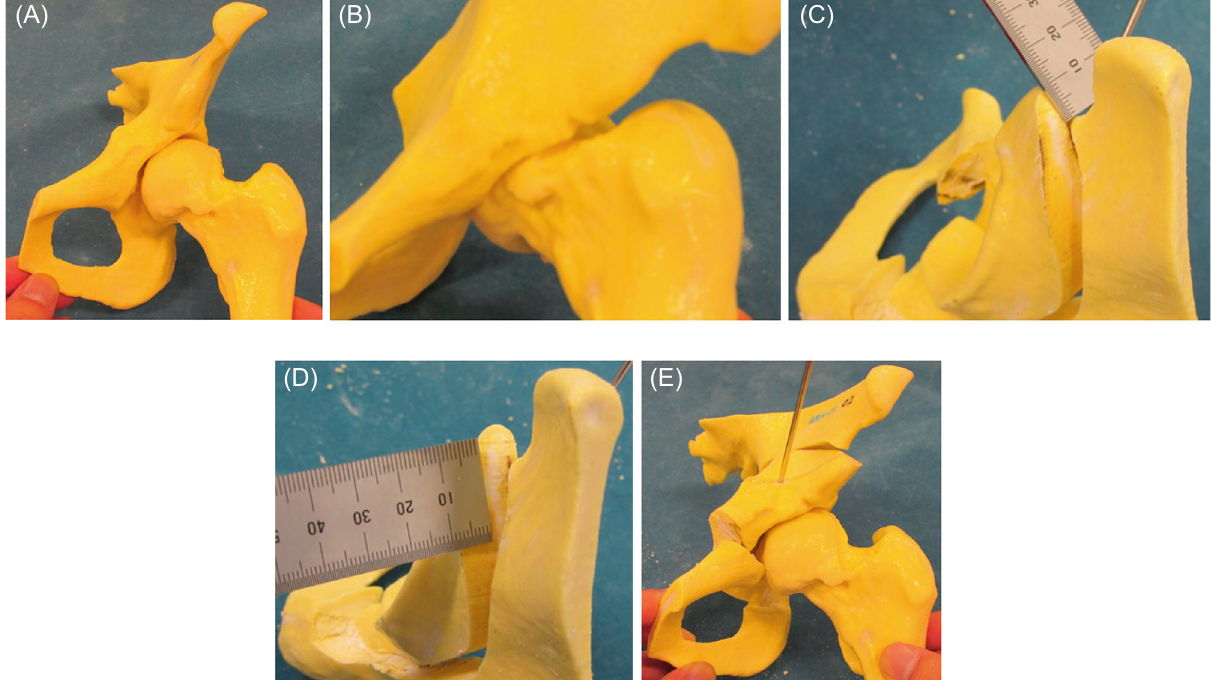
Figure 2. Three-dimensional salt-based model of hip (A); anterior impingement was simulated at general PAO position (B); the position of the fragment was 1 cm anterior (C) and lateral (D) from the original position was considered appropriate to avoid anterior impingement